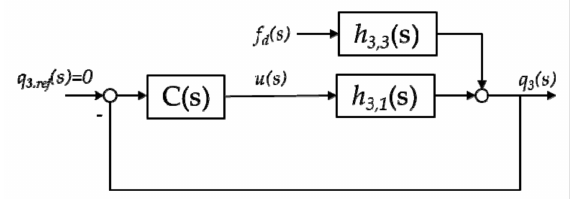
Figure 16. Sketch of the closed-loop system with the non-collocated VATMD for the six-mass system.